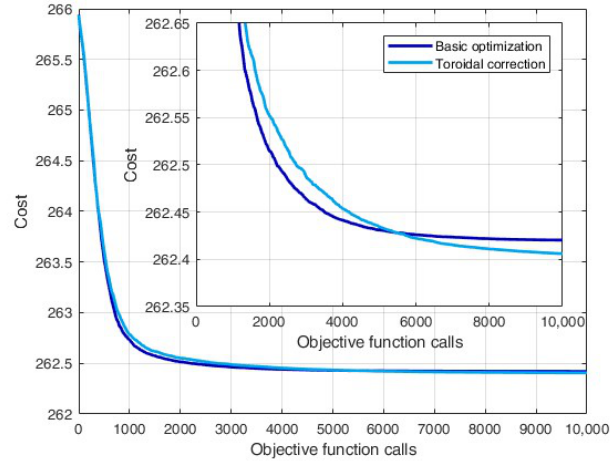
Figure 11. Comparison between the basic optimisation and the one with toroidal correction.